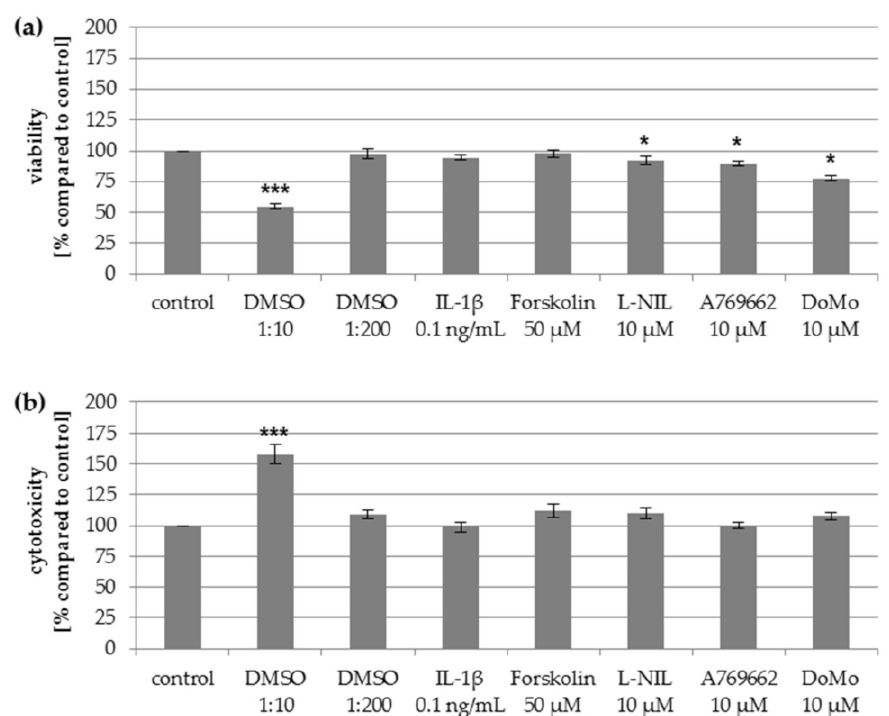
Figure 4. Impact of mediators used on ( a ) viability and ( b ) cytotoxicity of chondrocytes as measured by the LIVE/DEAD viability/cytotoxicity kit, which determines the percentage of living and dead cells. Viability and cytotoxicity values of treated cells are reported as percentage ± SD of control (unstimulated cells), set as 100%. Statistical differences vs. unstimulated cells, Wilcoxon signed-rank test, *** p < 0.005 and * p < 0.05. DoMo: Dorsomorphin